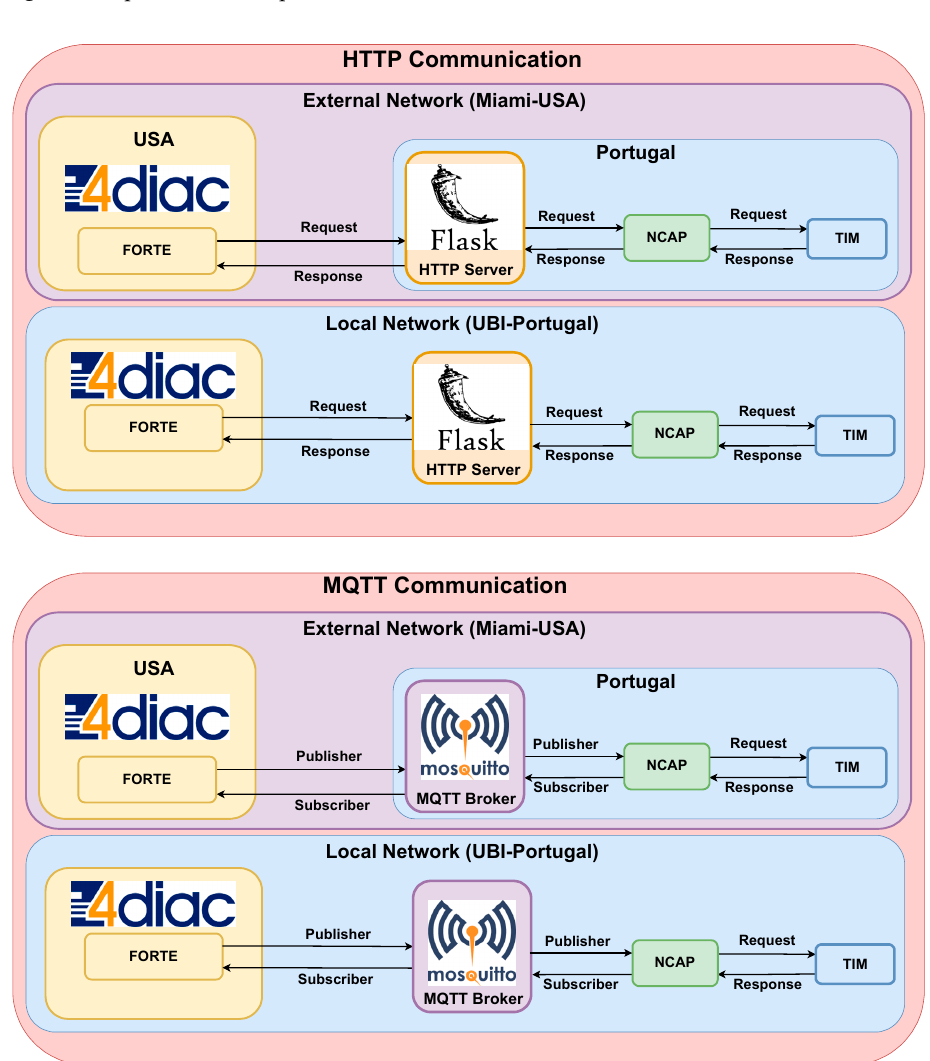
Figure 6. HTTP and MQTT communication.